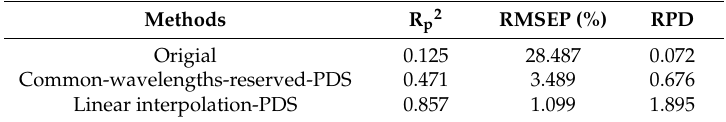
Table 4. Performances of calibration transfer methods for the total soluble solid contents of Ruby Seedless based on least-squares support vector machine (LS-SVM).